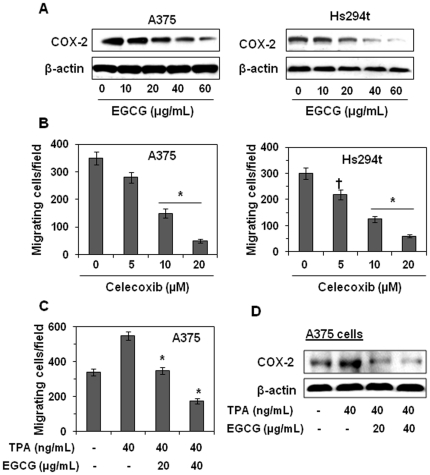
EGCG inhibits invasion of melanoma cells by reducing endogenous COX-2 expression.(A) Treatment of A375 and Hs294t cells with EGCG for 24 h resulted in down-regulation of COX-2 protein expression. (B) Treatment of A375 and Hs294t cells with celecoxib, an inhibitor of COX-2, for 24 h inhibits melanoma cell migration in a dose-dependent manner. The data are expressed as the mean number of migratory cells± SD/microscopic field. Significant difference versus non-celecoxib-treated control cells, *
P<0.001; †
P<0.05. (C) Treatment of A375 cells with EGCG (20 and 40 µg/mL) inhibits TPA (a COX-2 stimulator)-enhanced cell migration capacity. The data on cell migration capacity are summarized in terms of mean number of migrating cells/microscopic field ± SD, n = 3. Significant inhibition versus TPA treatment alone, *
P<0.001. (D) EGCG down regulates TPA-induced COX-2 expression in A375 cells. The levels of COX-2 were determined in cell lysates using western blot analysis.